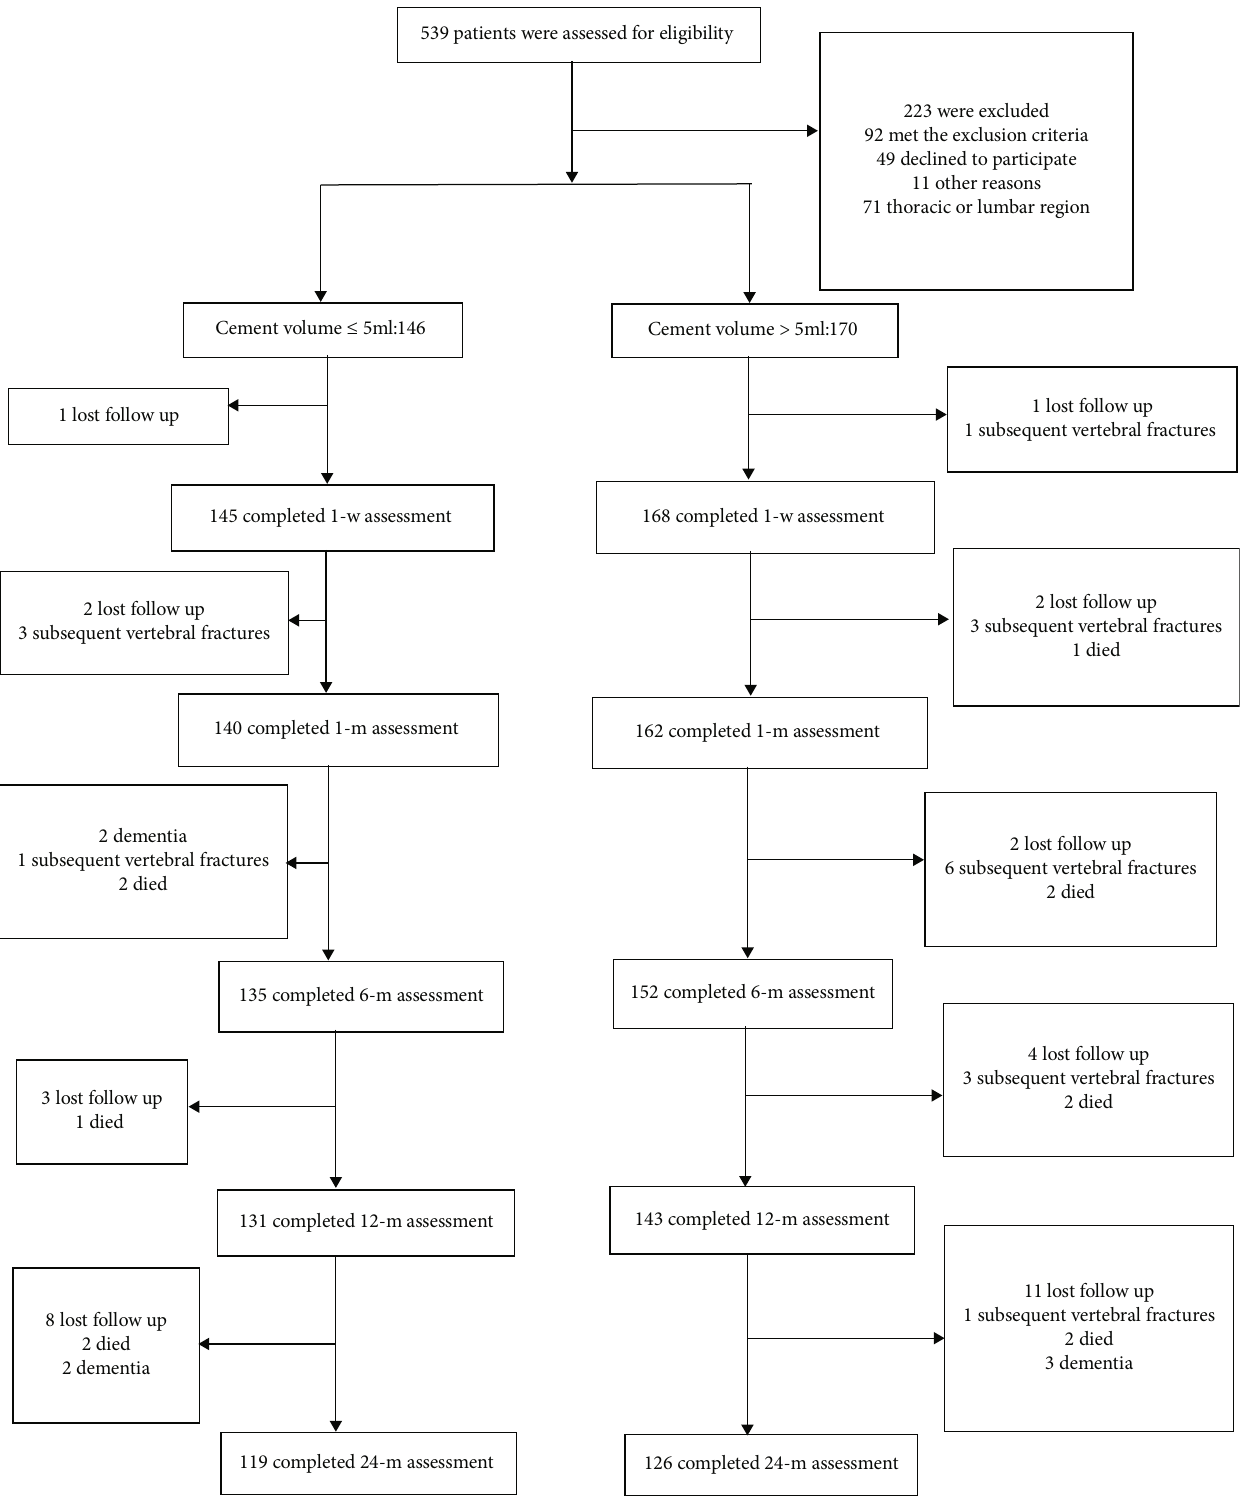
Figure 2: Flow chart of including, excluding, and dividing cases and 2-year